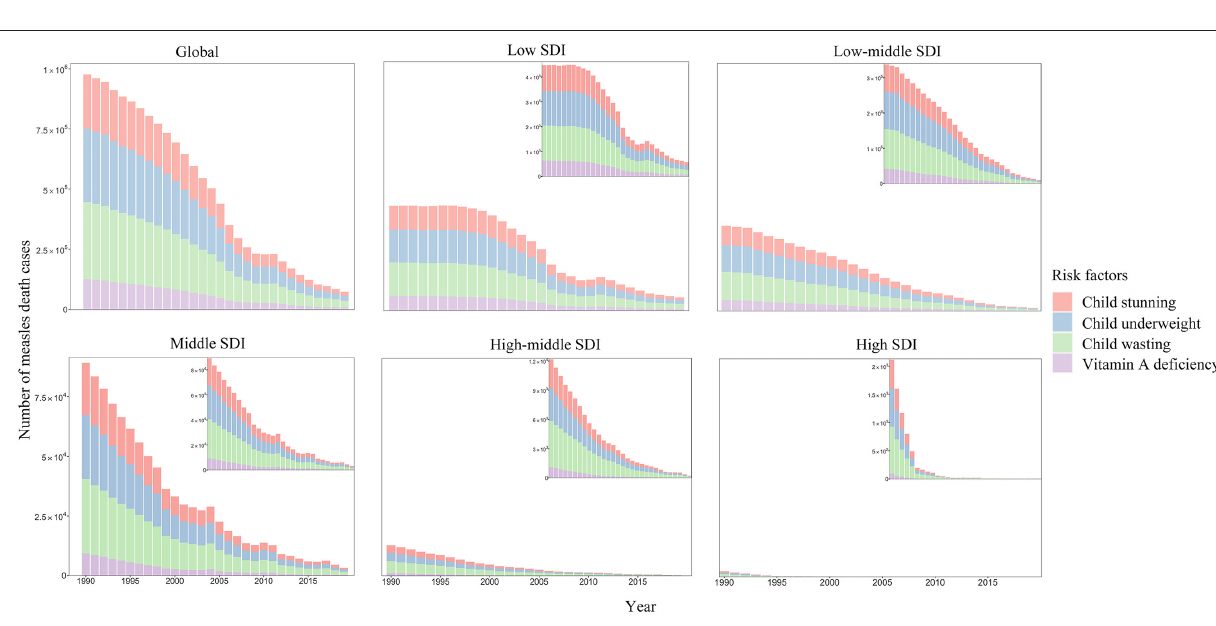
FIGURE 6 | The number of measles death cases by risk factors and SDI regions. SDI, socio-demographic